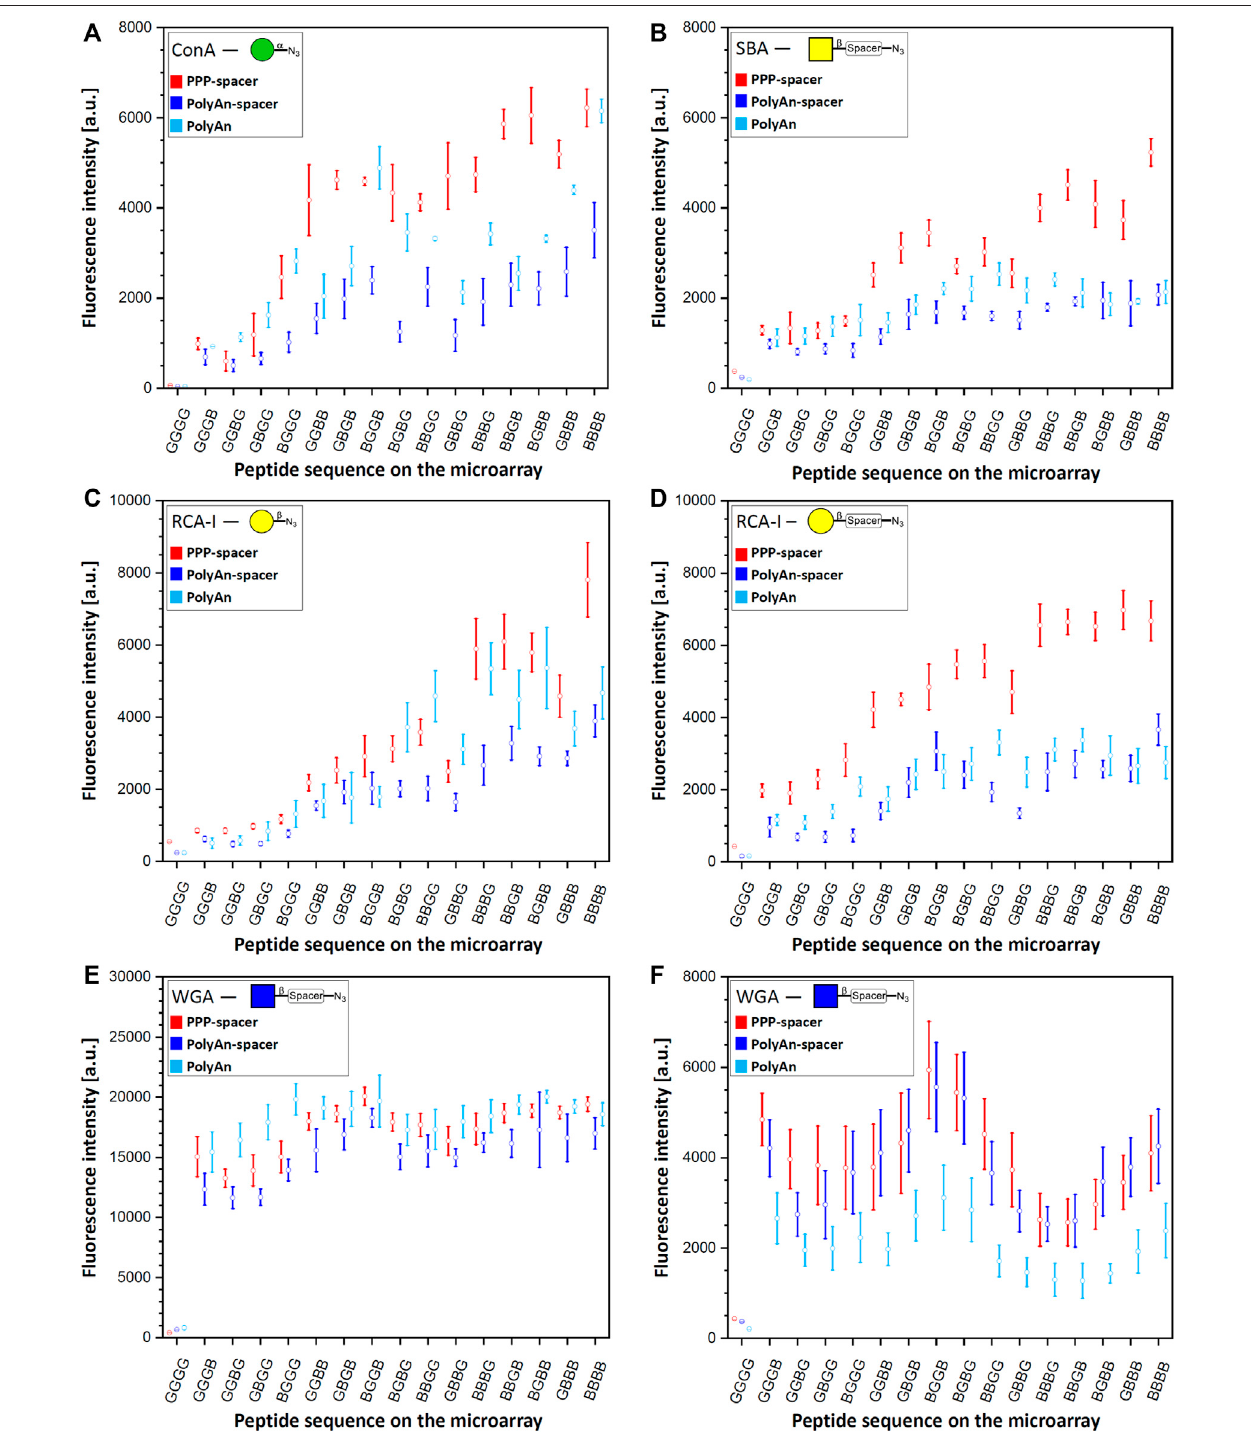
FIGURE 3 | Fluorescence staining intensities of respective sugar azides 3 , 4 , 5 , 7 and 9 with their corresponding lectins: (A) α -Man azide 3 with ConA (CF ® 633 labeled, 100 μ g/mlconcentration), (B) β -GalNAc-PEG3 azide 7 withSBA (rhodaminelabeled, 10 μ g/ml concentration) (C) β -Gal azide 4 with RCA-I (rhodaminelabeled, 10 μ g/ml concentration), (D) β -Gal-PEG3 azide 5 with RCA-I (rhodamine labeled, 10 μ g/ml concentration), (E) β -GlcNAc-PEG3azide 9 with WGA (rhodamine labeled) with10 μ g/mlconcentration,and (F) 0.2 μ g/mlconcentrationonPEPperPRINTslideswithPEG-spacer(PPP-spacer;red),andonPolyAnfunctionalizedslideswith (dark blue) and without PEG-spacer (light blue).